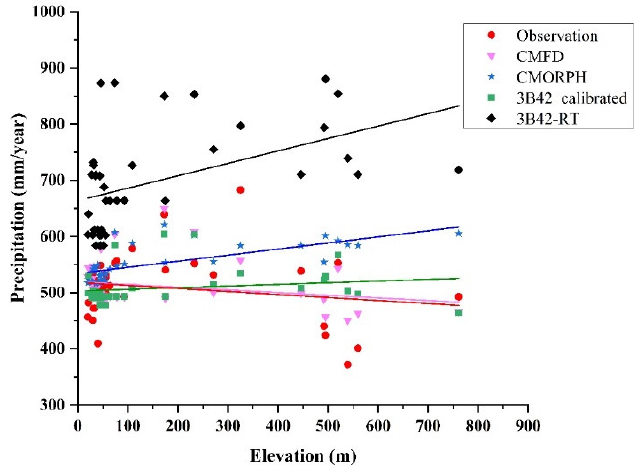
Figure 10. Scatter points showing annual precipitation values from ground observations at 36 stations against elevation, compared with four satellite-derived products.